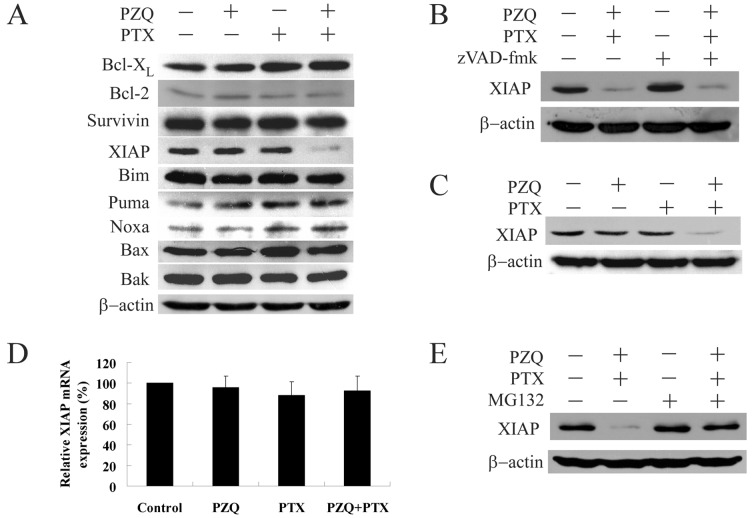
The co-treatment of PZQ and PTX could suppress XIAP protein.(A) DLD-1 cells were treated with 20 µM PZQ alone, 10 nM PTX alone, or the combination for 24 h. Then expression of Bcl-XL, Bcl-2, Survivin, XIAP, Bim, Puma, Noxa, Bax and Bak were monitored by Western blot. (B) After exposure of DLD-1 cells to a combination of 20 µM PZQ and 10 nM PTX in the presence or absence of 20 µM zVAD-fmk for 24 h, expression of XIAP was determined by Western blot. (C) H1299 cells were treated with 20 µM PZQ alone, 10 nM PTX alone, or the combination for 24 h, after which expression of XIAP was examined. (D) After DLD-1 cells were treated as in (A), total RNA was isolated and XIAP mRNA was quantified by real-time RT-PCR. Following normalization to GAPDH mRNA, the XIAP mRNA expression values for each condition were relative to vehicle-treated control cells. (E) DLD-1 cells were treated with a combination of 20 µM PZQ and 10 nM PTX in the absence or presence of 10 µM MG132 for 24 h, and then expression of XIAP was monitored by Western blot. Values represent mean±SEM from three separate experiments.